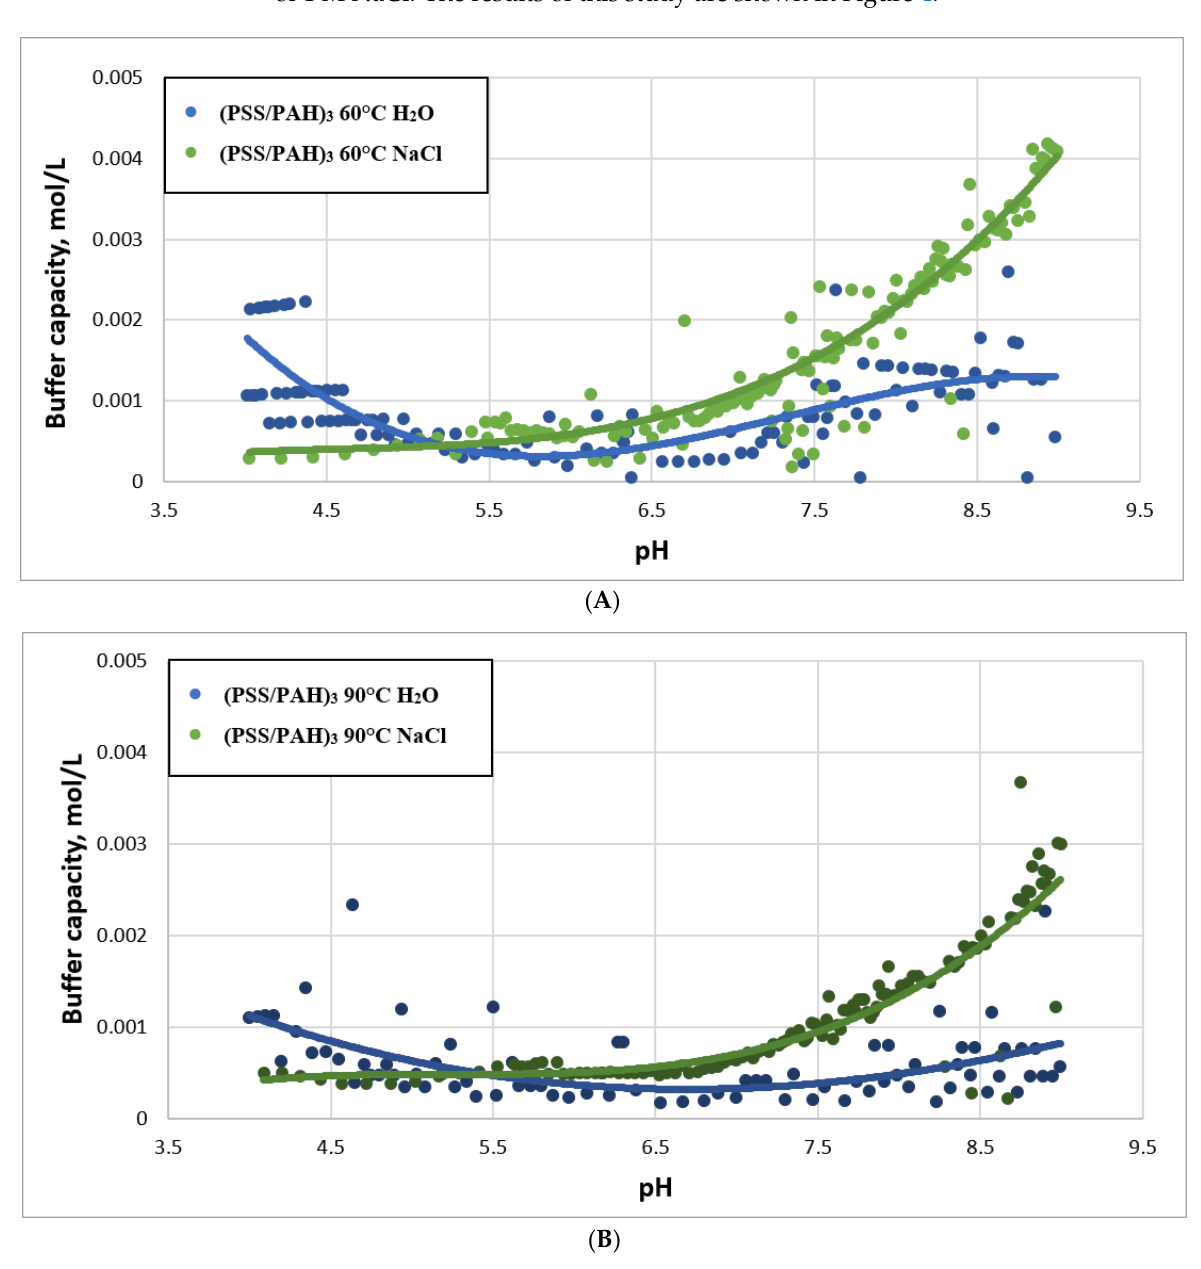
Figure 3. Buffer capacity of PMC composition (PSS/PAH) 3 at different pH after hour incubation at the 24 °C, 60 °C and 90 °C.